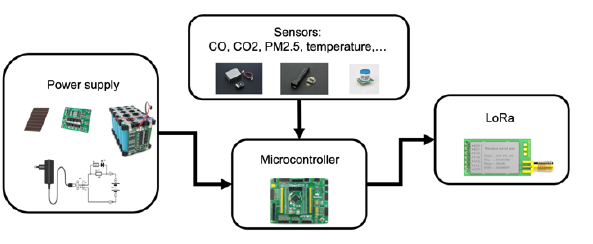
Figure 3. the architecture of our sensor nodes